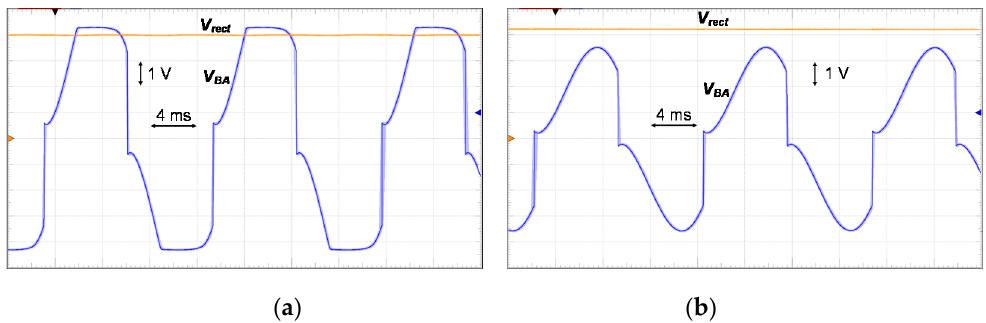
Figure 13. Measured waveform of the PE voltage V BA and the rectified voltage V rect ( a ) in the P-SSHI mode, and ( b ) in the S-SSHI mode.